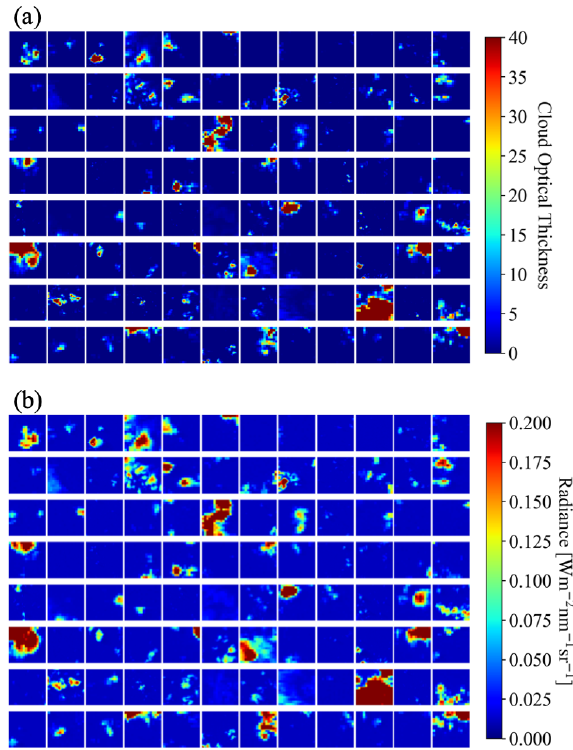
Figure B1. Illustrations of 64 × 64 tiles of (a) cloud optical thick- ness from LES data and (b) calculated 3D radiance at 600nm from EaR 3 T for CNN training.